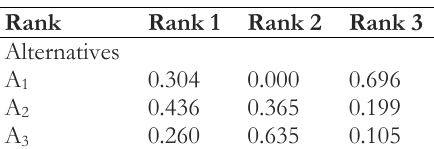
Table 14. Matrix γ.